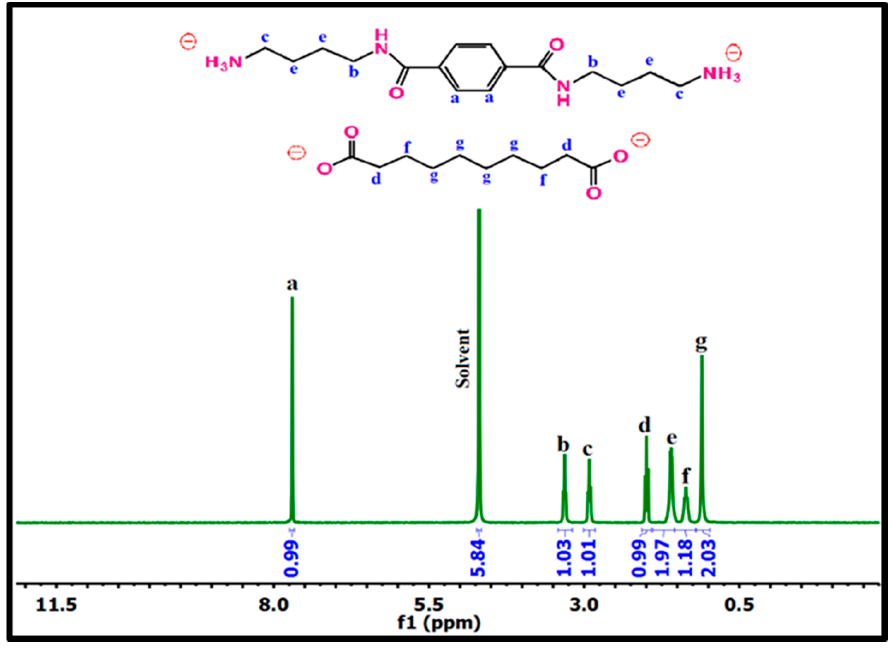
Figure 3. 1 H NMR spectra of BABT/SA salt.